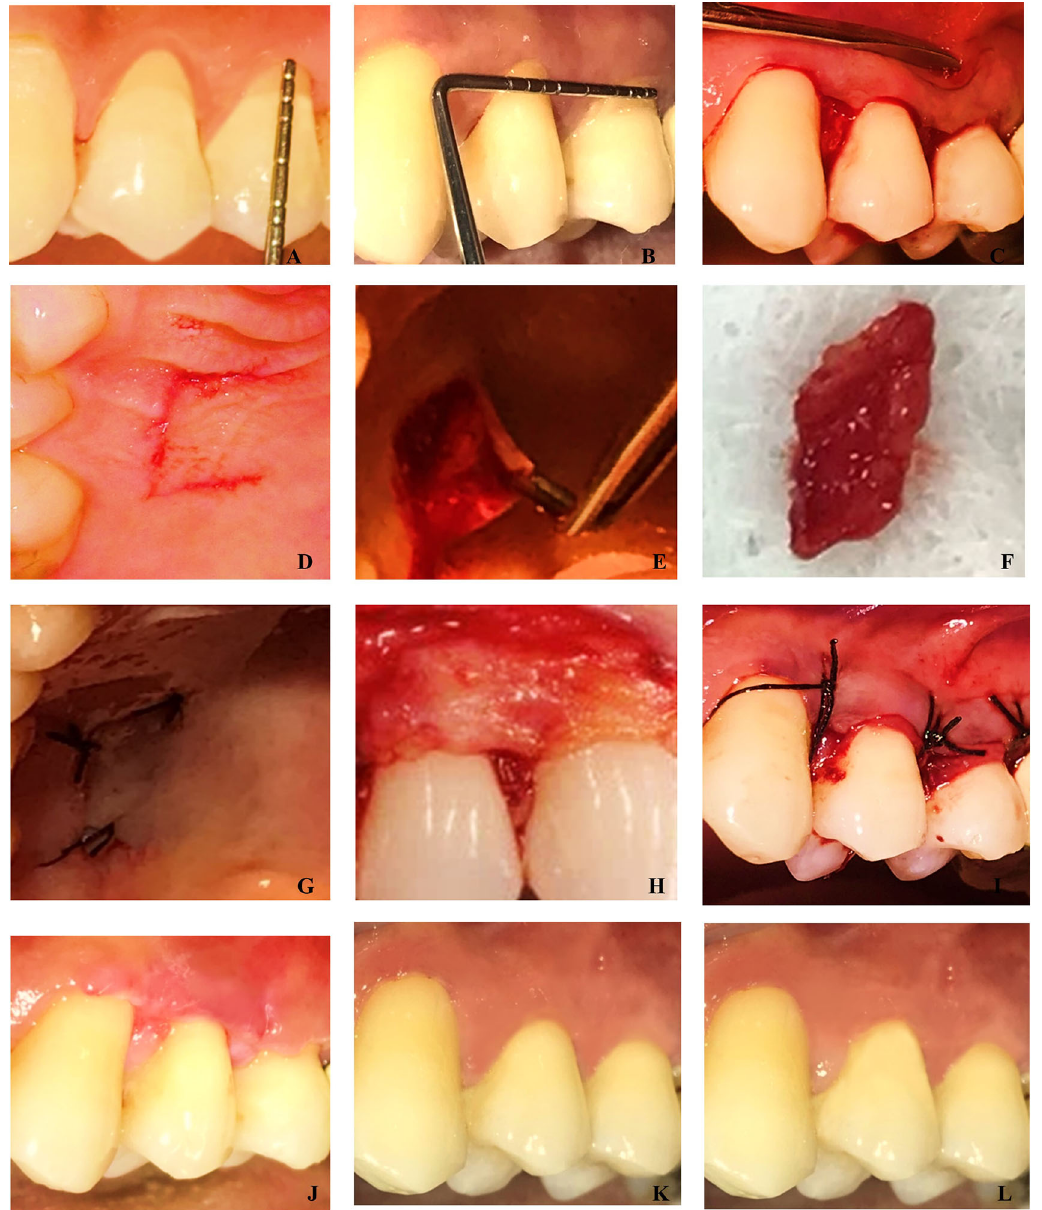
Figure 2.A&B:Pre-operative recessiondepthand widthmeasurementof theCAF+CTGGroup.C:Split-full-split thicknessflapreflected.D:TrapdoorincisionforharvestingCTGE:HarvestingoftheCTG.F:Connectivetissue graft. G: Suturing at the donor site H: CTG placed on the defect site. I: Flap coronally positioned and sutured with independent sling sutures. J: 15 days post-operative view of the site. K: 3 Months post-operative view. L: Six months post-operative view of the site treated by